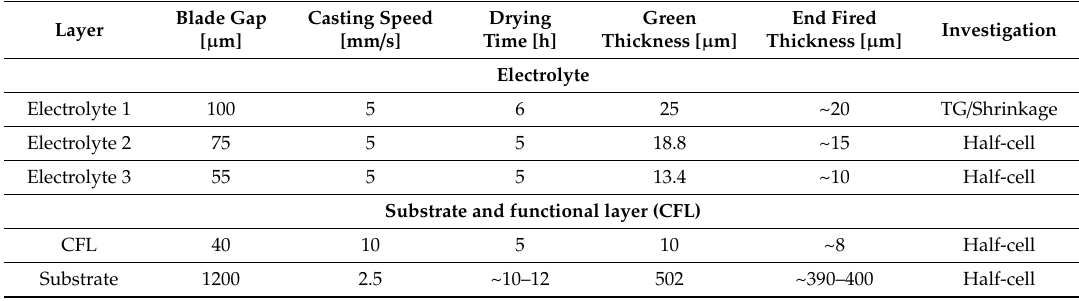
Figure 2. The sequential multi-layer processing technique of half-cell and the obtain microstructure after sintering at 1350 ◦ C / 5. Table 2. Summary of the tape-casting parameters, Adjusted casting speed, and blade gaps used for fabrication of the proton-conducting